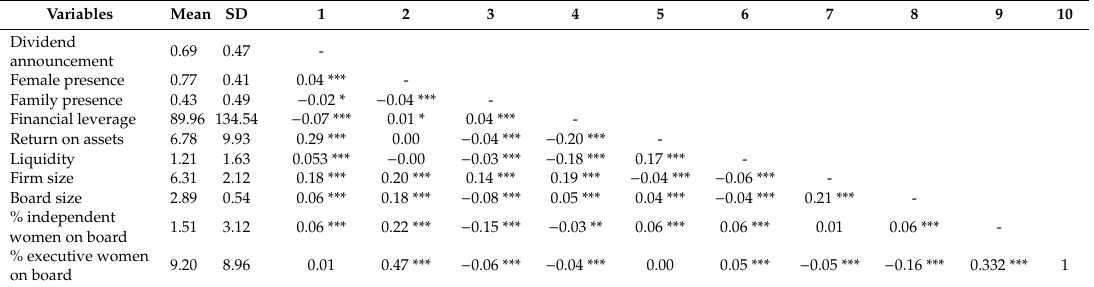
Table 4. Values of variables.